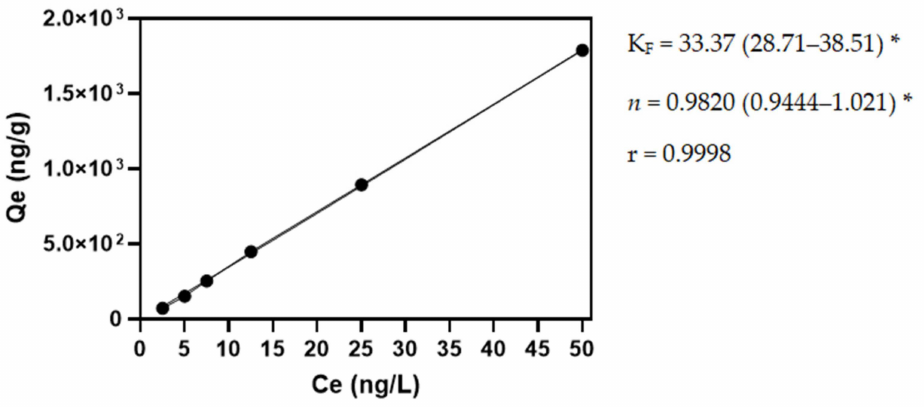
Figure 1. Freundlich adsorption isotherm of ADSI cork powder for TCA in a model wine solution. Qe is the amount of TCA adsorbed at equilibrium; Ce is the equilibrium concentration; * denotes the 95% confidence interval.